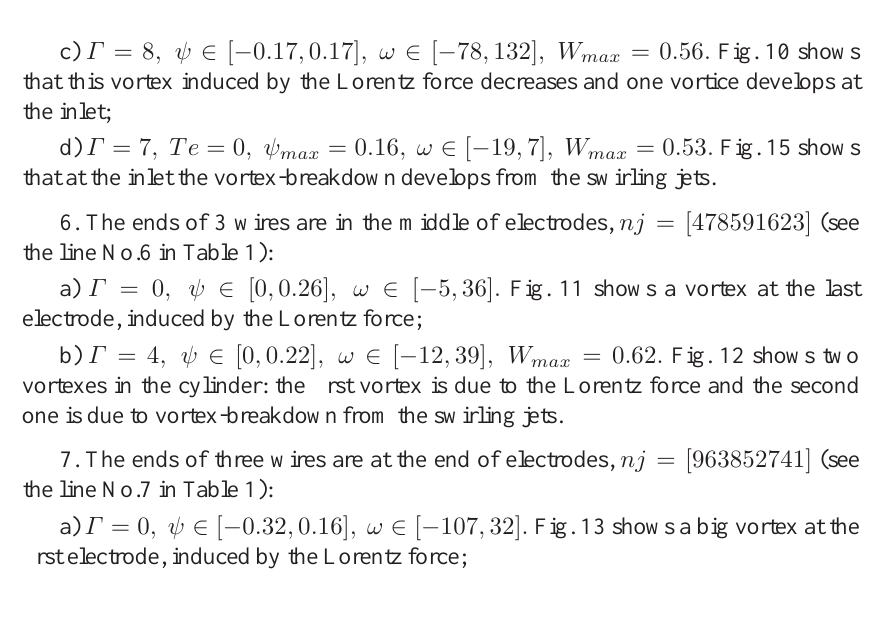
Figure 10. The stream functions for nj = [531642789] , ψ ∈ ( − 0 . 17 , 0 . 17) , Γ = 8